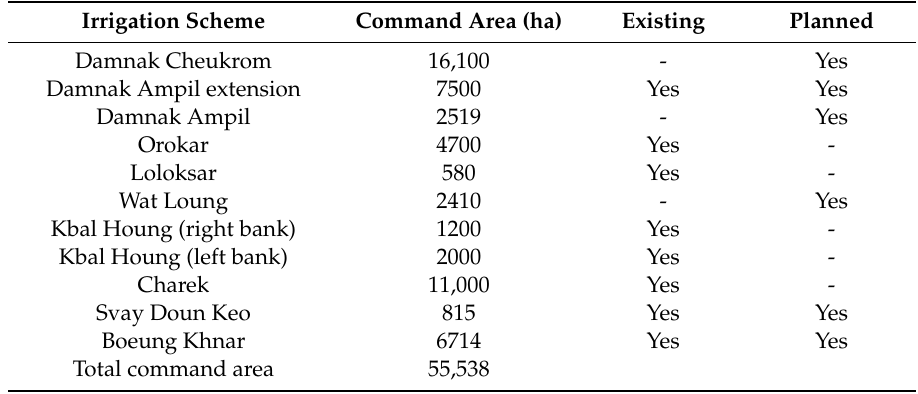
Table 2. Summary of irrigation scheme projects with command area in the PRB. Irrigation